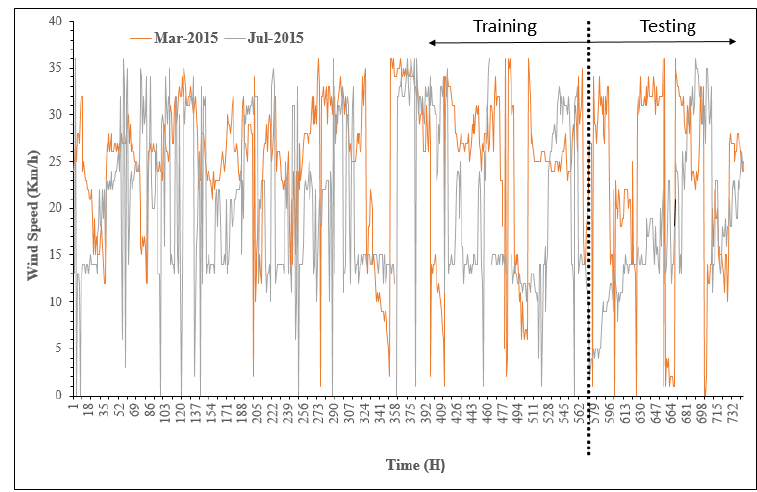
Figure 1. Time series of the wind speed in Halifax, Canada.